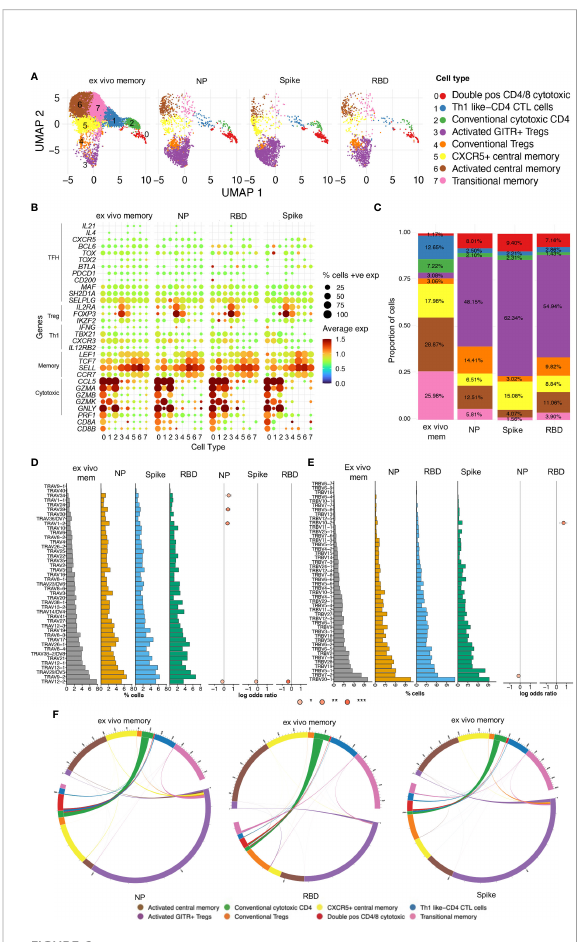
FIGURE 6 Single-cell RNAseq reveals heterogenous subsets and diverse TCR usage within SARS-CoV-2 reactive CD4+ T cells. (A) UMAP showing 14,053 CD4+ T cells from CD25+CD134+ sorted cells from Ab high subjects split into 4 conditions: ex vivo memory; nucleoprotein (NP); Spike; and RBD. (B) Dot plot showing average expression of lineage genes and percentage of cellular expression within each cluster. (C) Enrichment of Treg populations in SARS-CoV-2-speci fi c CD4 in addition to central/transition memory and cytotoxic subsets. (D) Diversity of TCR alpha and (E) TCR beta chain in all 4 conditions. Few select TCRa/b enriched in stimulated conditions compared to ex vivo memory expressed as log odds ratio with adjusted p values including Bonferroni correction. (F) Circos plots showing little transition of cell types between ex vivo memory and stimulated